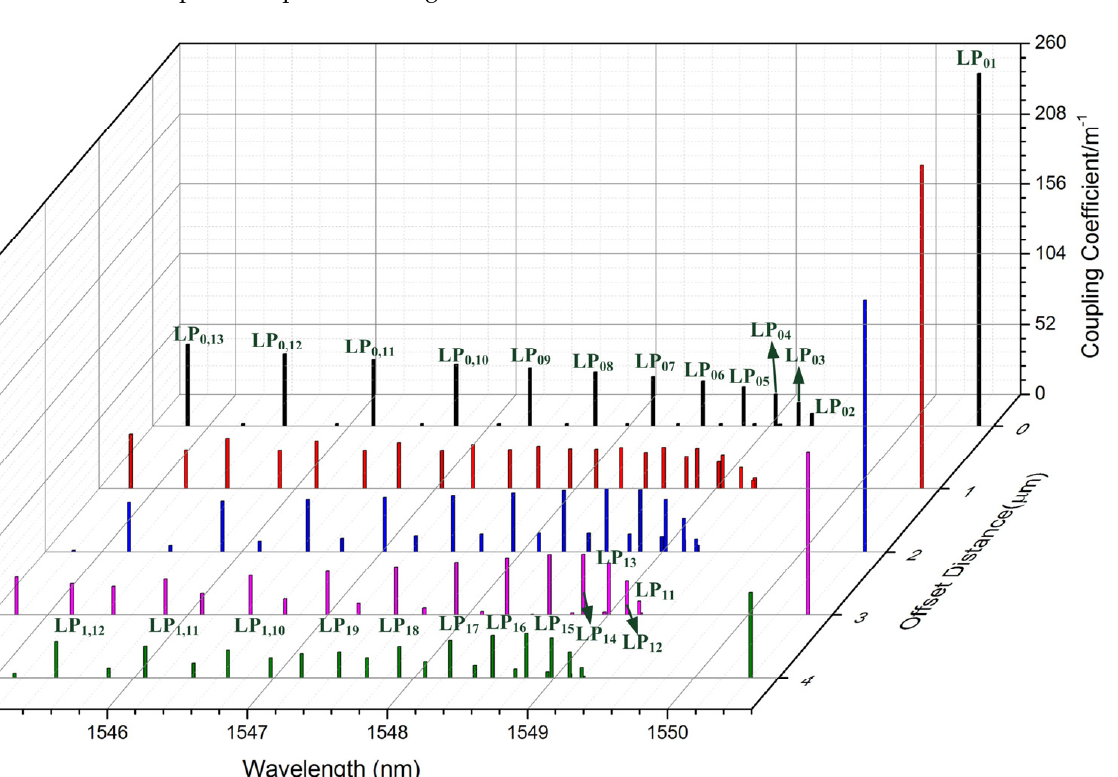
Figure 6. Coupling coefficients of LBL-FBG with different offset distance ( Δ d ).